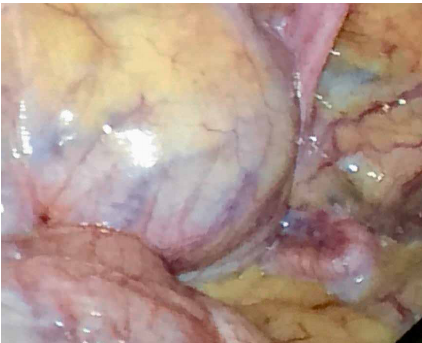
Figure 3: Intra-abdominal view of the pelvis. In the top left corner is the bladder, and the bottom left corner is the colon. The fallopian tube can be seen resting on the omentum in the bottom